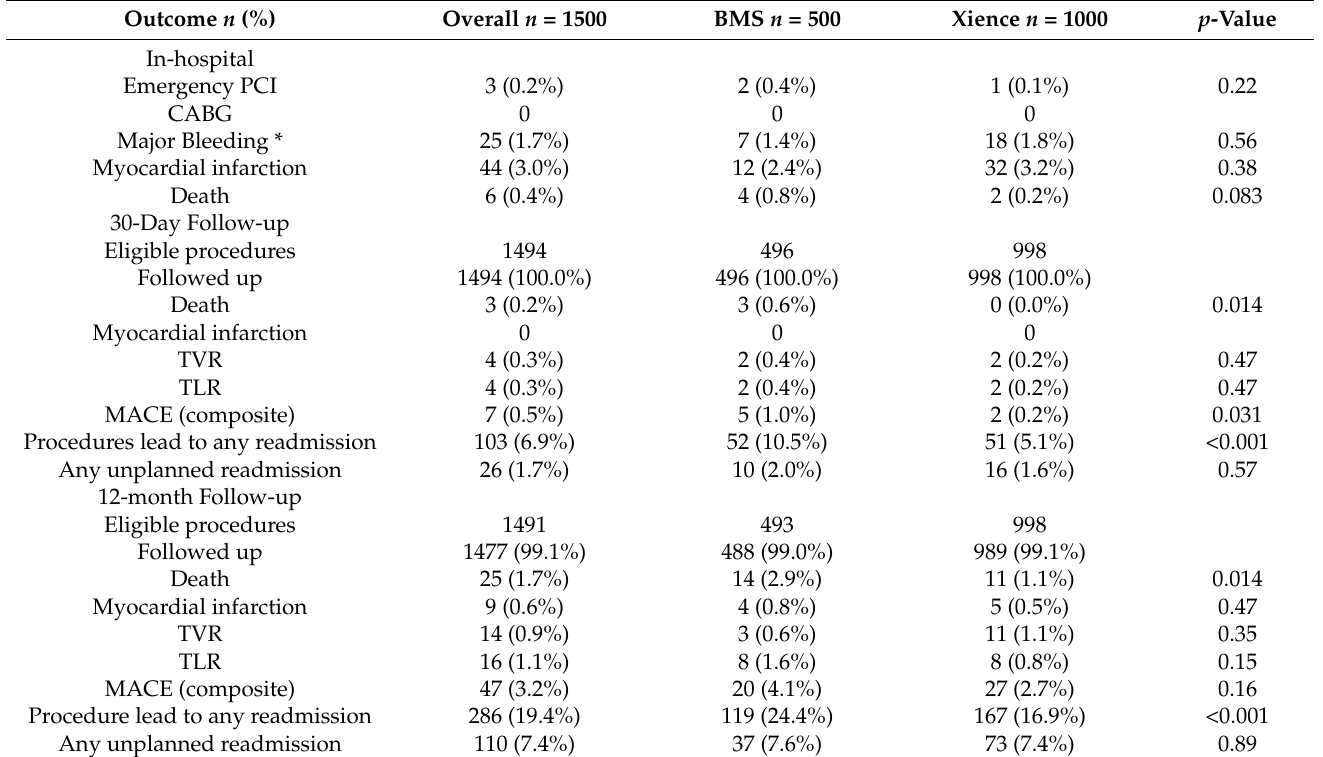
Table 3. Clinical Outcomes in Hospital, at 30 days and 12